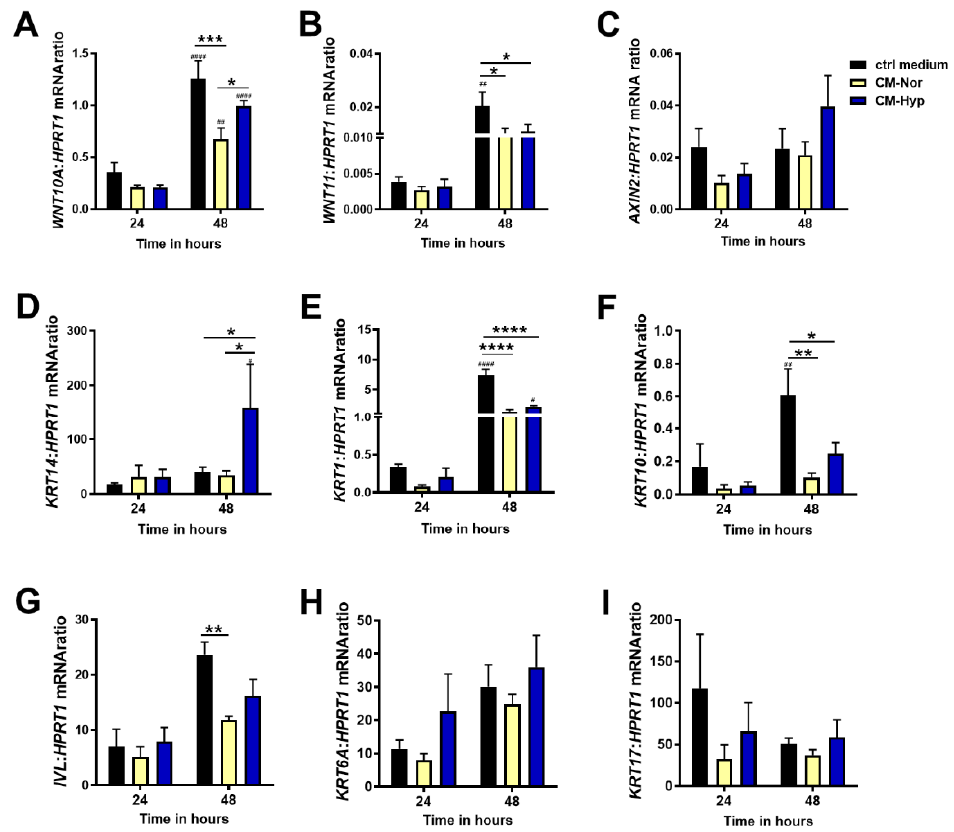
Figure 5. Quantitative analysis of ( A ) WNT10A , ( B ) WNT11 , ( C ) AXIN2 , ( D ) KRT14 , ( E ) KRT1 , ( F ) KRT10 , ( G ) IVL ,( H ) KRT6A , and ( I ) KRT17 mRNA expression in pKERs exposed for 24 and 48 h to CM-Nor (yellow bars) or CM-Hyp (blue bars) relative to control-treated cells (black bars). The results are shown as the mean ± SD. The asterisks indicate significant differences between specific mRNA expression at 48 h (* p < 0.05; ** p < 0.01; *** p < 0.001; **** p < 0.0001). Hashes show significant differences in mRNA between 24 and 48 h of culture ( # p < 0.05, ## p < 0.01, #### p < 0.0001). Abbreviations: pKERs, pig keratinocytes; CM-Nor, conditioned medium collected from pASCs exposed to normoxia; CM-Hyp, conditioned medium collected from pASCs cultured under hypoxia.